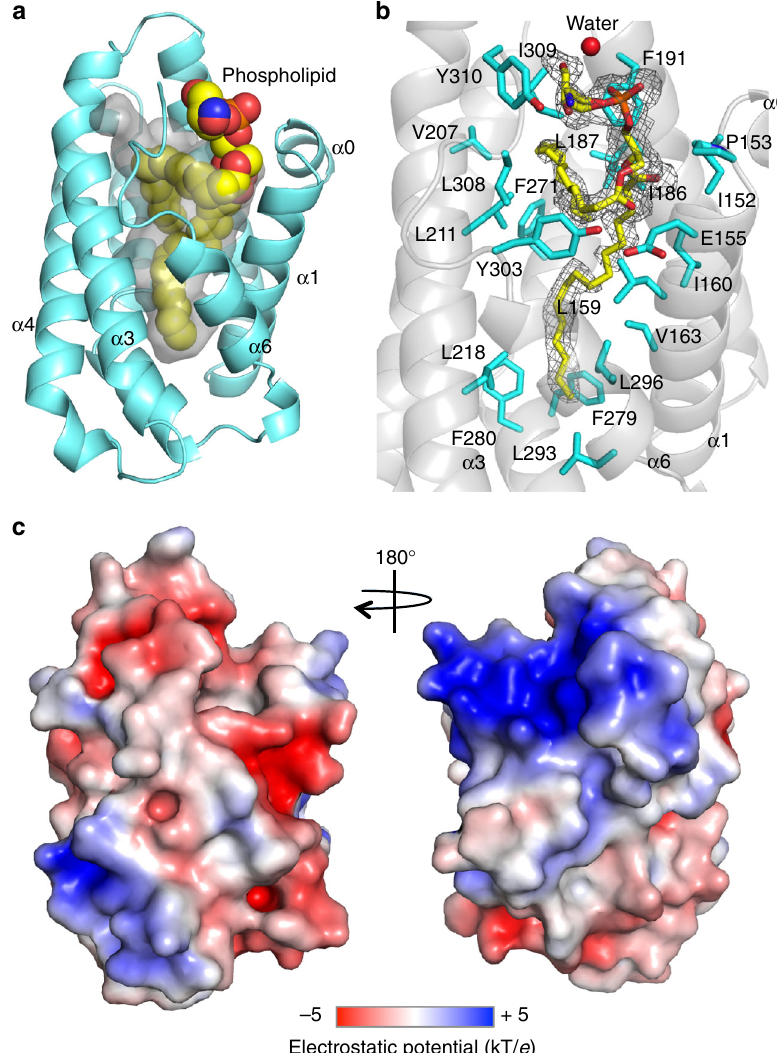
Fig. 1 Crystal structure of the G protein-binding domain of Gip1. a Overall structure of Gip1(146 – 310) and a phospholipid represented by a cartoon and ball model. The surface of the cavity is shown in grey. b Residues and water within van der Waals distance from the phospholipid. The phospholipid is shown with the 2mFo-DFc electron density map contoured at 1.0 σ . The water is shown as a red ball. c Electrostatic potential at the molecular surface of Gip1 (146 – 310), ranging from blue ( + 5 kT/ e ) to red ( − 5 kT/ e